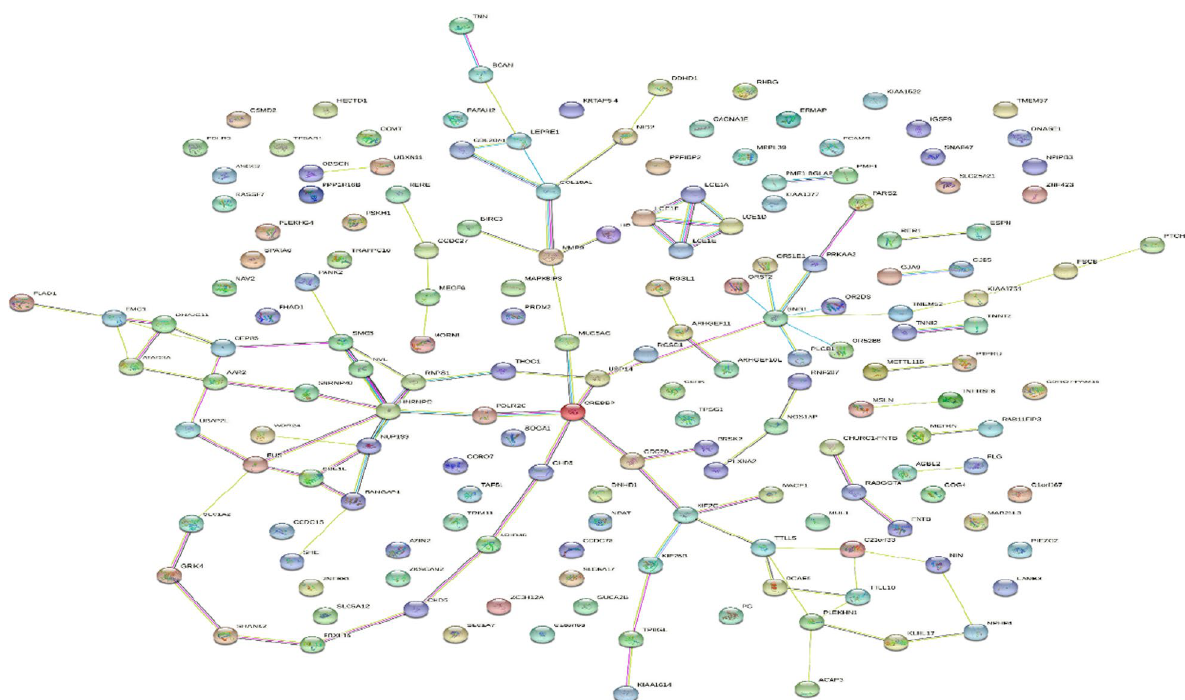
Fig. 10 String Diagram on Protein–Protein Interaction. The genes that make up the network’s centre nodes (the main genes) and its edges (the genealogical connections between proteins and their pathways) are